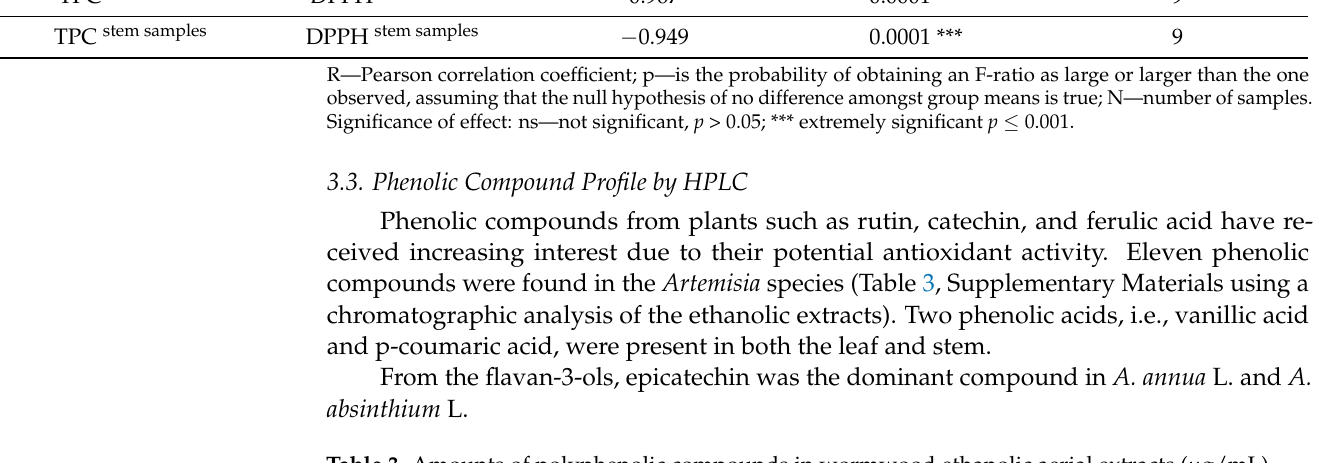
Table 3. Amounts of polyphenolic compounds in wormwood ethanolic aerial extracts ( µ